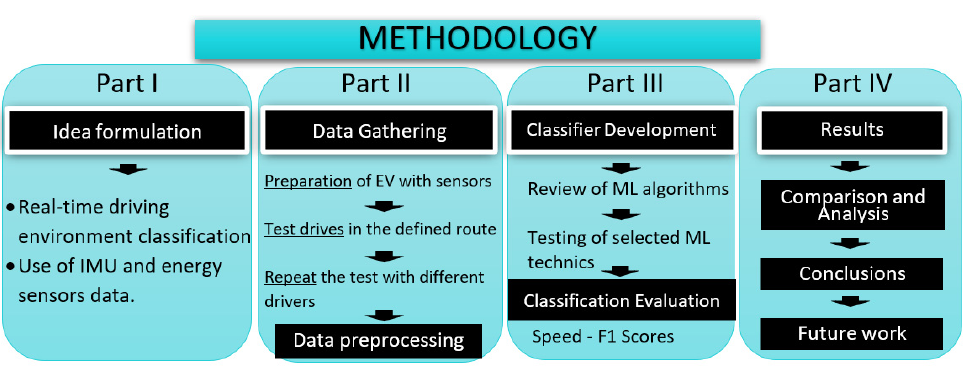
Figure 3. Experimentation and algorithm design process (provisional).